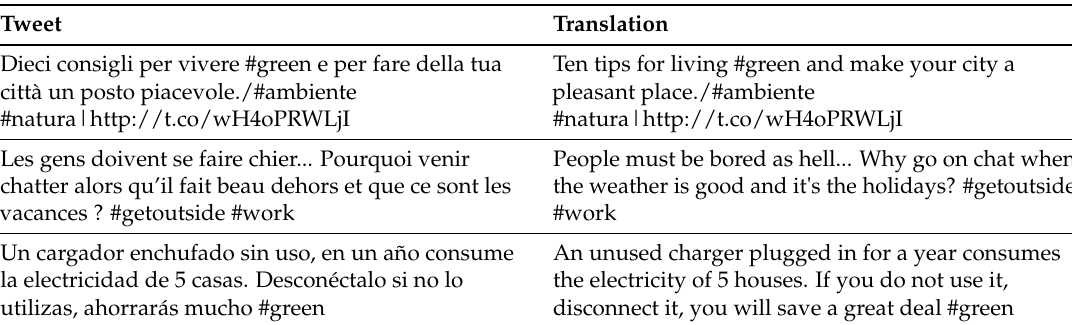
Table 4. Tweets in non-English